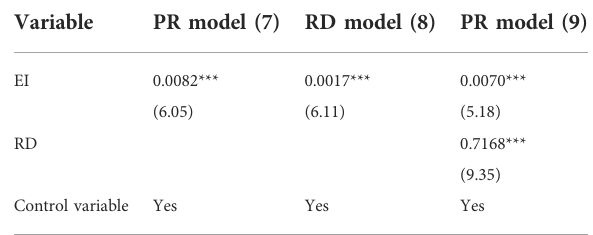
TABLE 7 Mediation test and estimated